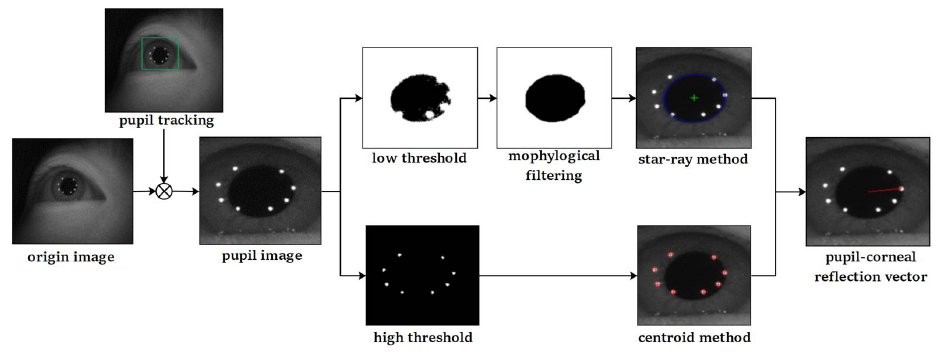
Figure 2. Pupil and Purkin spot-detection process.